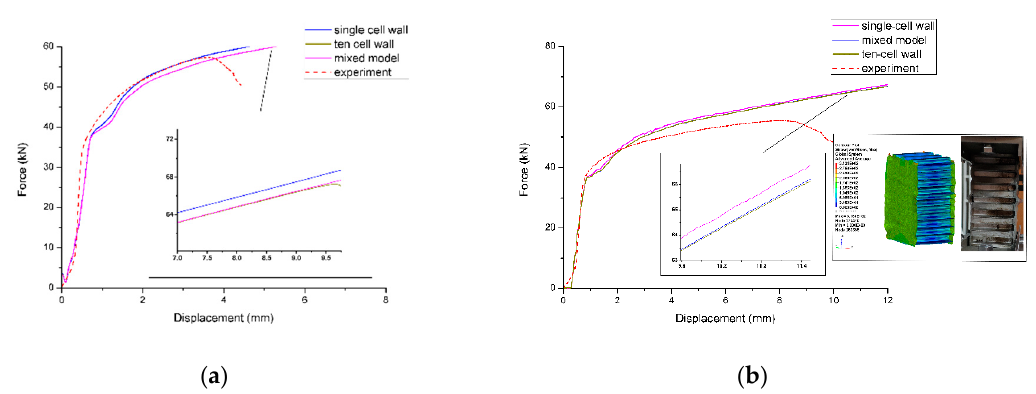
Figure 8. ( a ) Results of the BAHP under in-plane compression in the transverse direction; ( b ) Results of the BAHP under in-plane compression in the longitudinal direction.